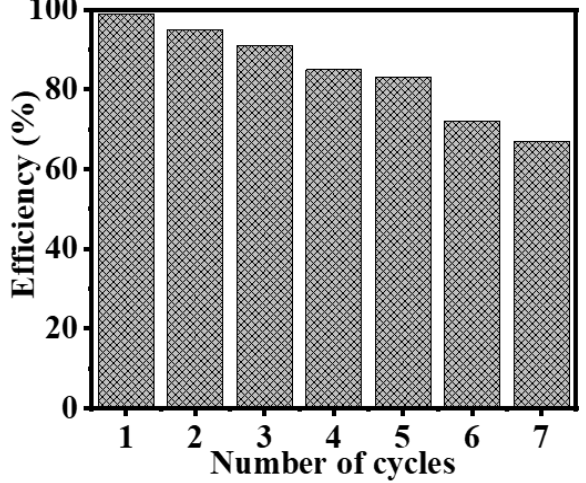
Figure 10. Reusability tests for Ni 75 Pd 25 @PVDF-HFP NFs membrane. The amount of catalyst, [SBH], and T are 100 mg, 1 mmol, and 298 K, respectively.